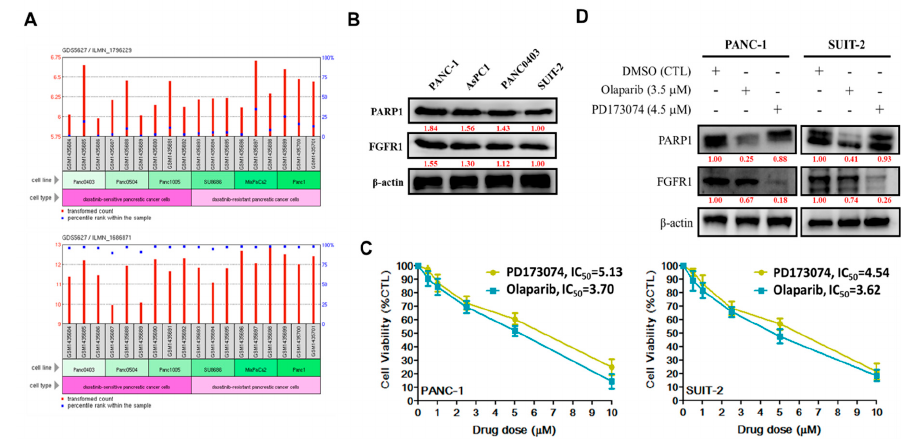
Figure 1. Enhanced FGFR1 and PARP1 expression characterizes FGFR1 inhibitor-resistant pancreatic cells at mRNA and protein levels. ( A ) Histograms of the FGFR1 (upper panel) and PARP1 (lower panel) RNAseq expression profile in dasatinib-sensitive PANC0403, PANC0504, and PANC1005 cells compared with dasatinib-resistant SU8686, MiaPaCa2, and PANC-1 pancreatic cancer cells in the GSE9357/GP10558/GDS5627 cohort. ( B ) Representative Western blot data showing the differential expression of FGFR1 and PARP in PANC-1, AsPC1, PANC0403, or SUIT-2 cells. ( C ) Line graphs showing the effect of 1–10 μ M PD173074 or olaparib on the viability of PANC-1 (left panel) or SUIT-2 (right panel) cells. ( D ) Representative Western blot images of the effect of 4.5 μ M PD173074 or 3.5 μ M olaparib on the expression level of PARP or FGFR1 protein in the PANC-1 and SUIT-2 cells. β -actin served as the loading control.